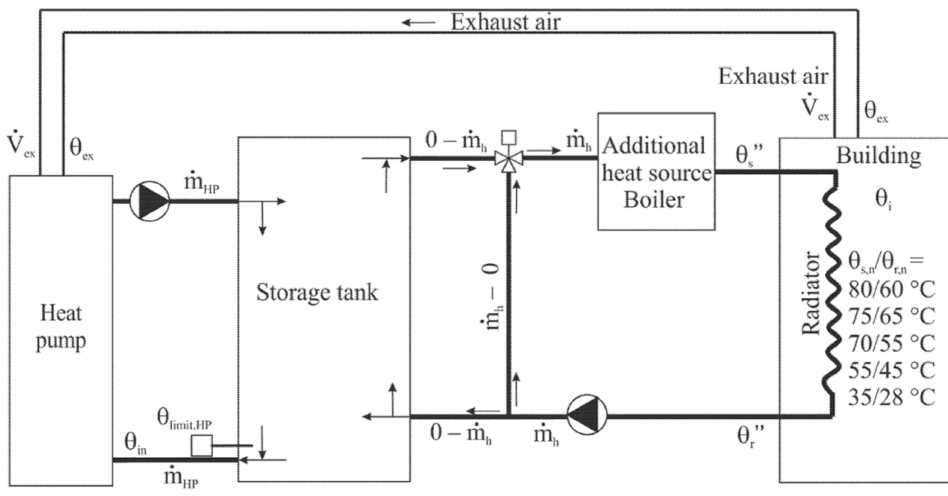
Figure 22. Schema of the system of heat recovery from exhausted air, presented in [11]. A system of two recovery exchangers as an idea to increase heat-recovery efficiency is analyzed in [127]. In summer, exhaust air is directed to the secondary heat exchanger to heat the air behind the cooler and then goes to the primary unit to pre-cool the fresh air. Compared to the baseline solution, with a single heat-recovery exchanger, the solution reduced the energy consumption of the cooler by more than 20% and that of the heater by